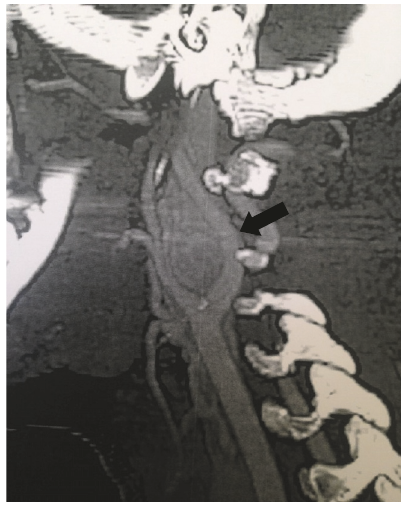
Figure 2: CTA-carotid body paraganglioma (CBP), lyre sign